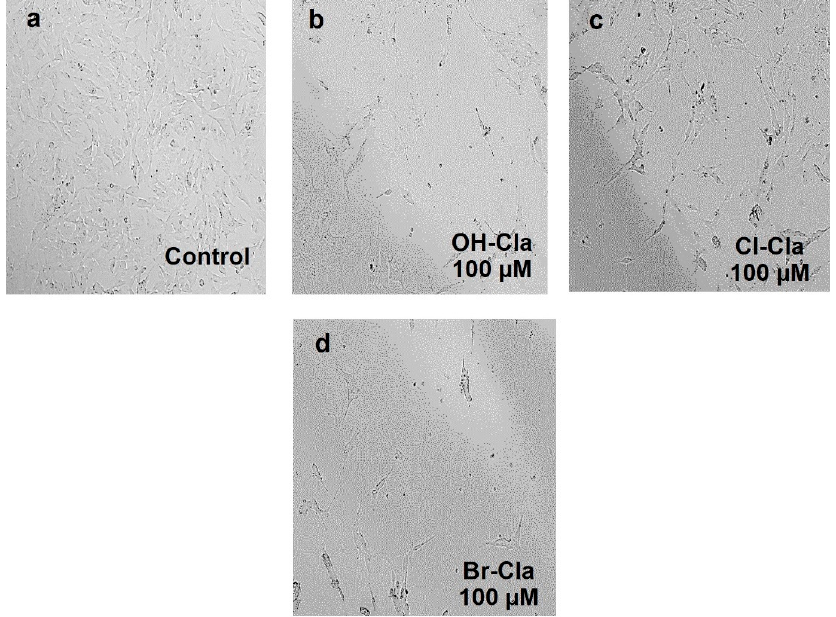
Figure 7. Microscopic cellular visualization of SH-SY5Y cells after 48 h of incubation with cell medium and ( a ) 0.1% DMSO (control), ( b ) OH-Cla, ( c ), Cl-Cla, or ( d ) Br-Cla. Representative images were obtained with a high contrast brightfield objective (10 × ) (LionHeart FX Automated Microscope), from three independent experiments.